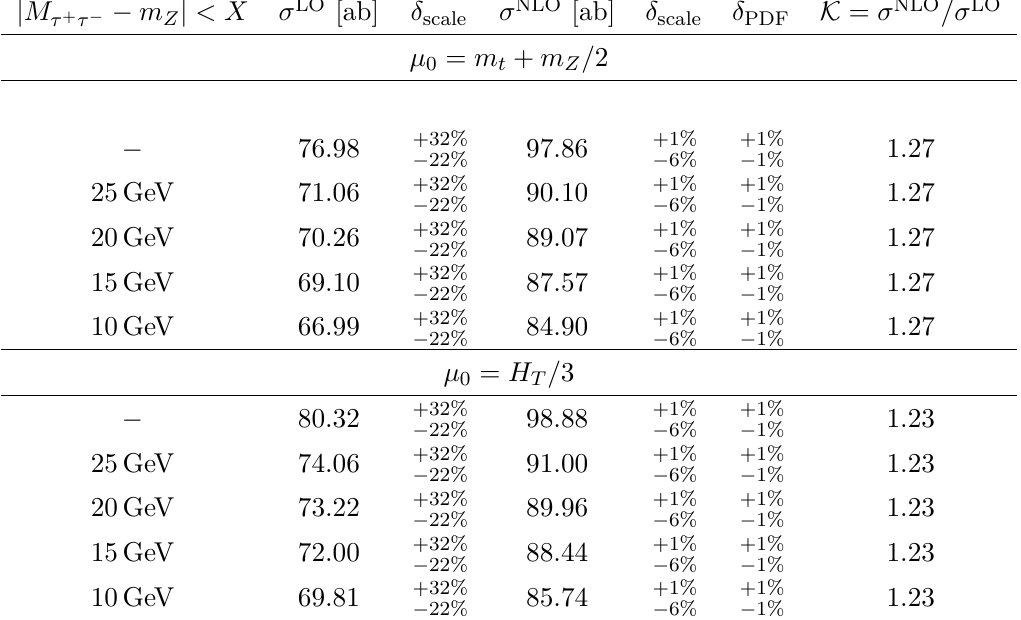
Table 5 . LO and NLO integrated fiducial cross sections for the pp → e + ν e µ − ¯ ν µ τ + τ − b ¯ b + X √ process at the LHC with s = 13 TeV. Results are evaluated using µ R = µ F = µ 0 with µ 0 = m t + m Z / 2 and µ 0 = H T / 3 . The LO and NLO NNPDF3.1 PDF sets are used. We display results for four different values of the M cut, where | M − m Z | < X with X ∈ (25 , 20 , 15 , 10) GeV. τ + τ − τ + τ − Additionally, the LO and NLO predictions without this requirement are given. The